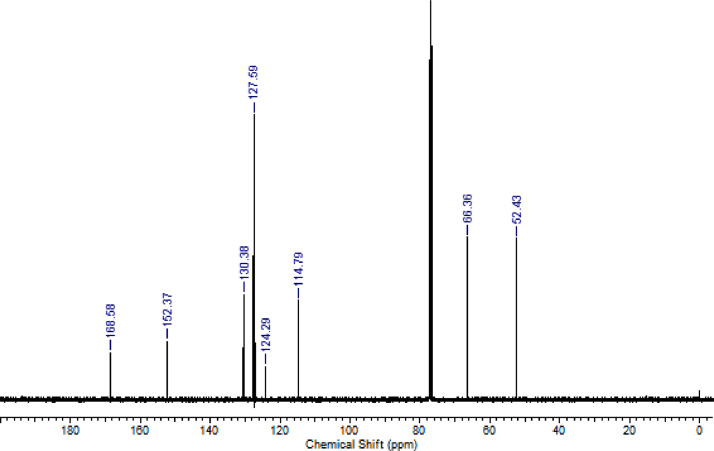
13C NMR (CDCl3, 100 MHz) spectrum of compound 6d